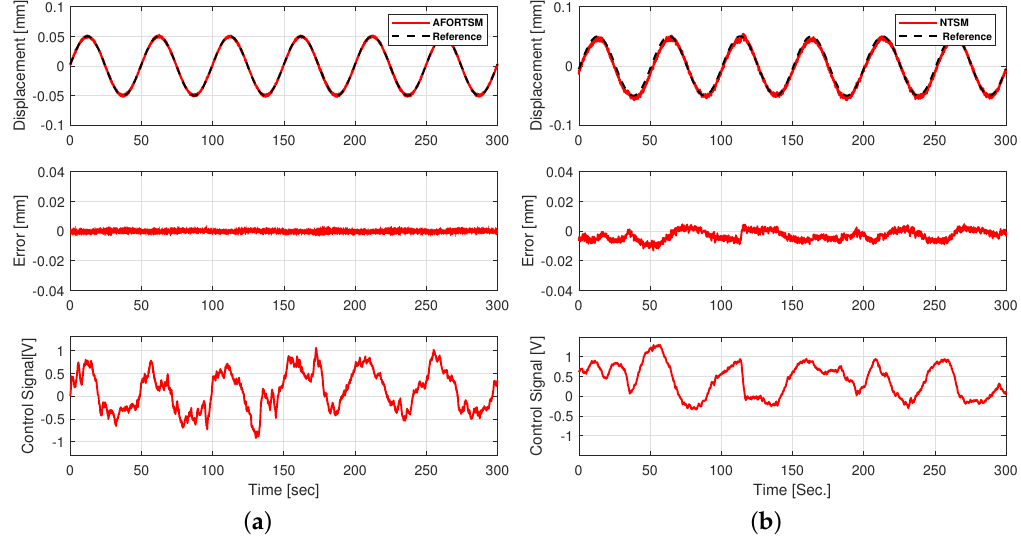
Figure 6. Test 5: Experimental results of AFORTSM and NTSM for tracking a single-tone sinusoidal reference with uncertainties (top: tracking profiles; middle: tracking error; bottom: control signal). ( a ) AFORTSM; ( b )